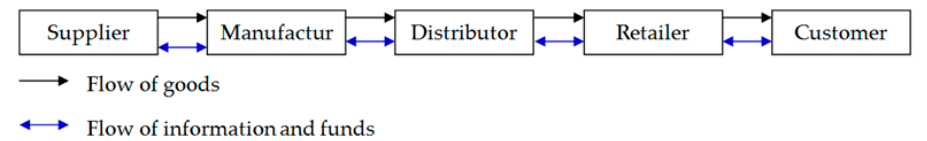
Figure 7. The basic supply chain (Adapted from: https://www.mdpi.com/2071 ‐ 1050/11/20/5751, accessed on 26 June 2020 [31]).